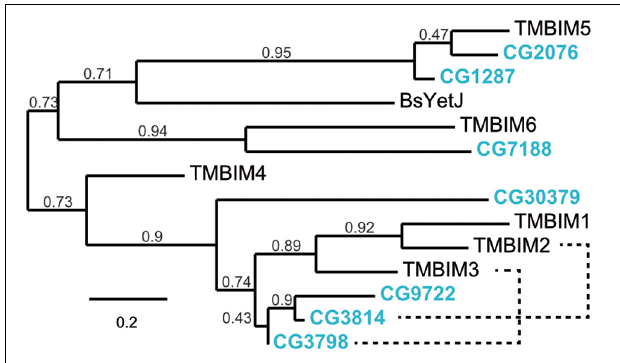
FIGURE 1 | Phylogenetic relationship of fly and human TMBIM proteins. Phylogenetic analysis of the sequence alignment of human and Drosophila TMBIM proteins identifies CG2076 and CG1287/Mics1 as orthologs for TMBIM5 and CG7188/BI-1 for TMBIM6, TMBIM4 is most probably CG30379 while the relationship of TMBIM1-3 to their fly orthologs is less clear. The bacterial homologue BsYetJ is most closely related to TMBIM5 and TMBIM6. The branch support values are indicated above the branches. The phylogenetic tree was created using the Maximum Likelihood algorithm with the BLOSUM62 substitution matrix and 100 bootstrap trials. The dashed lines indicate closest homologues according to BLASTP.